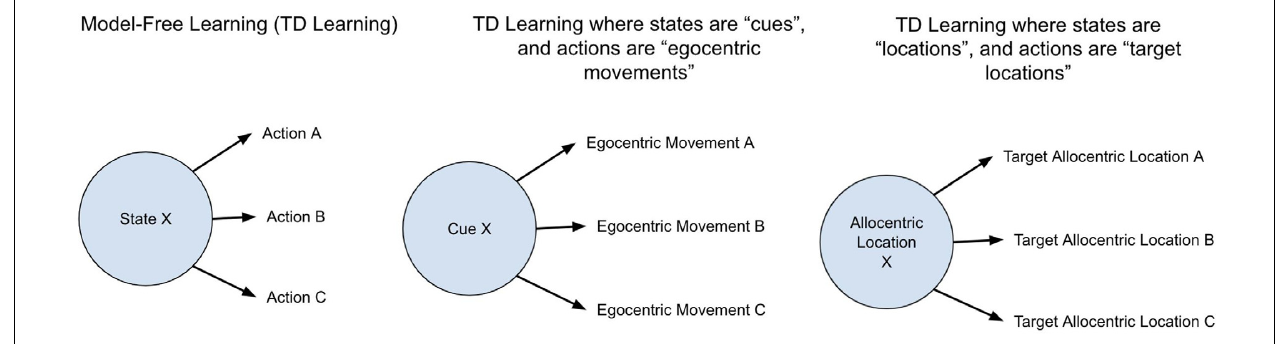
FIGURE 2 | Different implementations of decision making in model-free reinforcement learning. The general structure of model-free reinforcement learning is agents learn to predict the discounted reward of each given state and learn what actions tend to increase the expected discounted reward from each given state. The definitions of an “action” and “state” can be implemented differently. Most interpretations consider a “state” as a cue and an “action” as a specific egocentric movement. The proposal here is that the model-free learning of early vertebrates was such that “states” were allocentric locations, and “actions” were next target allocentric locations. This enabled model-free learning that was flexible to slight differences in starting locations and self-correcting to mistakes such as overshooting a goal